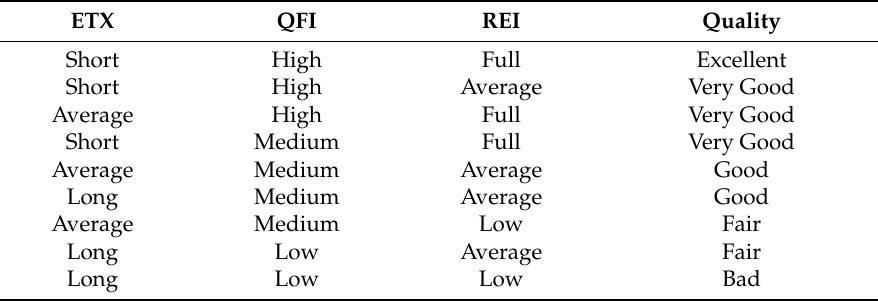
Table 2. Fuzzy rule base